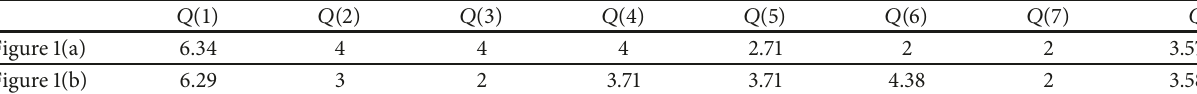
Table 1: Quantitative controllability indexes 𝑄 of each node and their average in Figure 1.